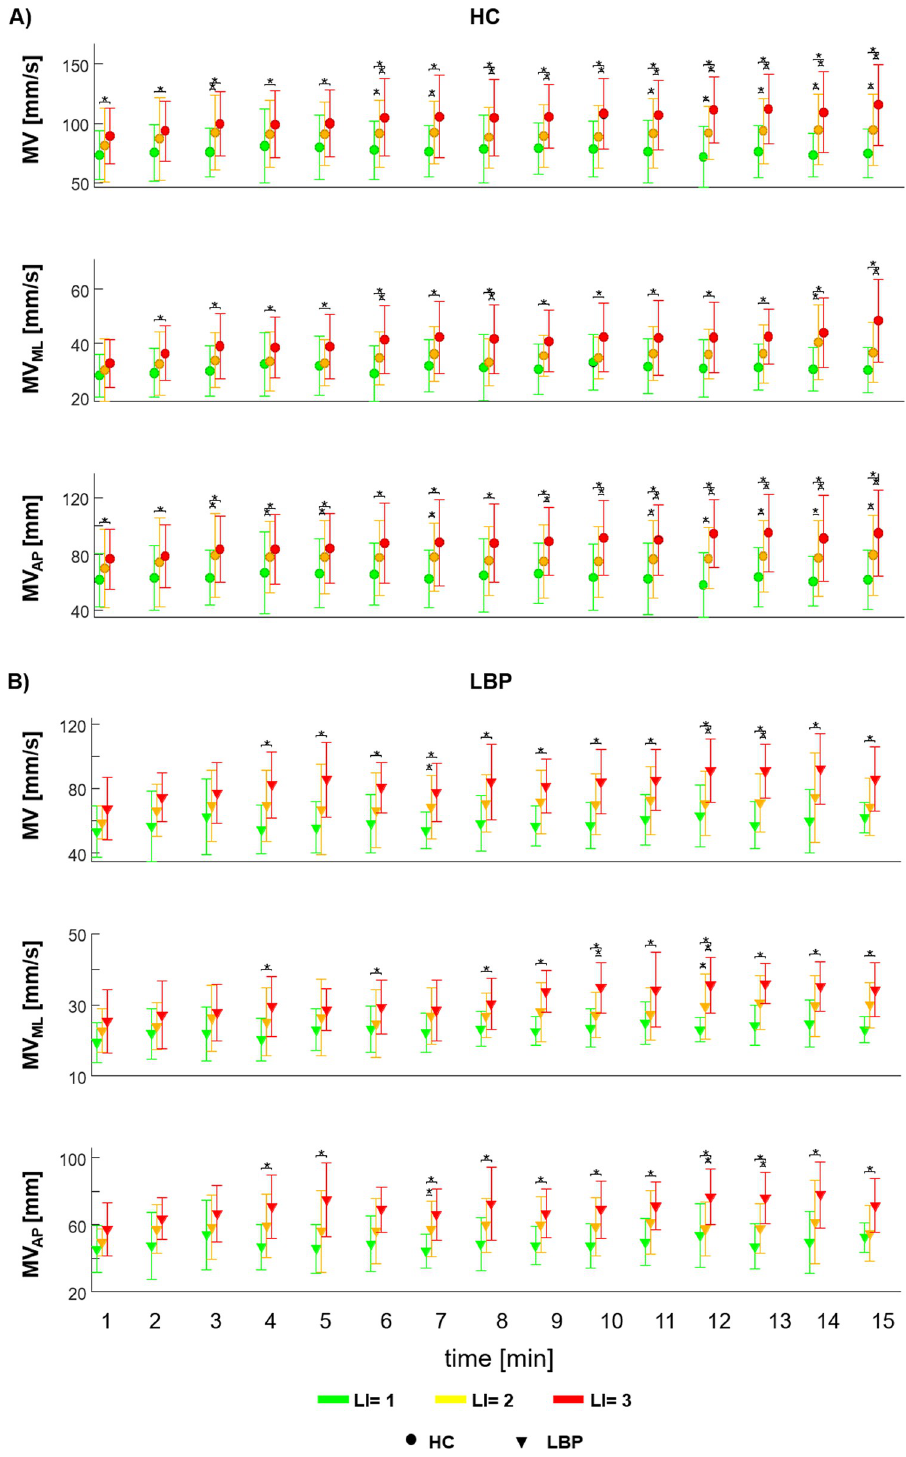
Fig 4. Centre of Pressure parameters across the 15 minutes lifting. Mean ± SD for each risk level in both groups (healthy control (A) and people with Low Back Pain (B)) for mean velocity in the average of the COP (MV) and in medio-lateral (MV ML ) and antero-posterior (MV AP ) directions considering all repetitions within each minute of the entire trail of lifting cycles. LI: Lifting index. � Statistical significance (p < 0.05).